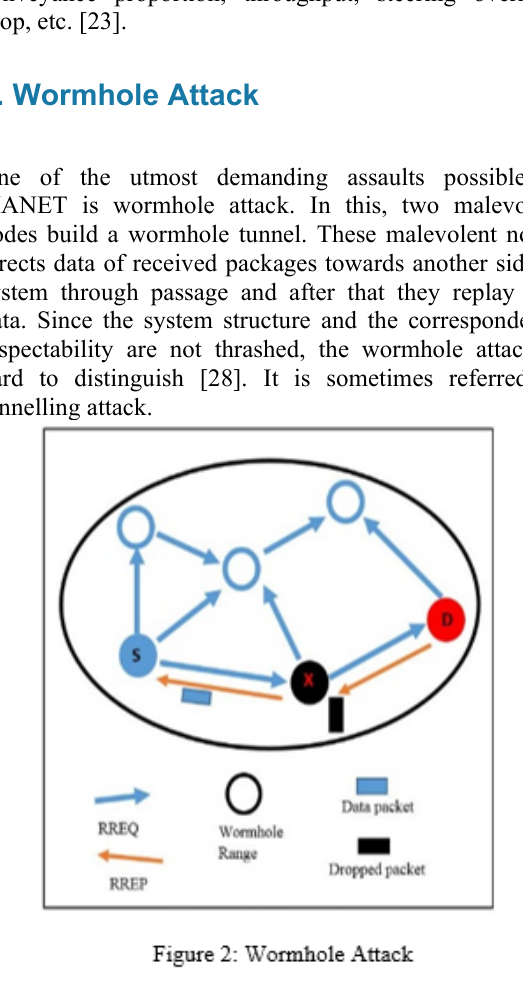
Figure 2 demonstrate that aggressor node in black color, with great broadcast power, covers source node in blue color and goal which is in red color and turned out to be the most limited middle of the road node to achieve goal D. The investigation of assault arrangement explored that; attacker dependably goes for dipping packages rather to divide content. In this manner, malevolent node or action can’t be recognized by any cryptographic or conventional security arrangements